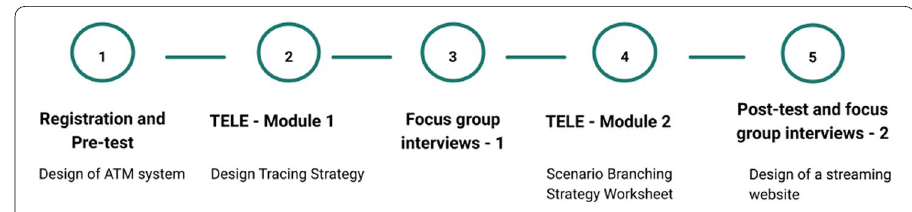
Fig. 13 Summary of the study